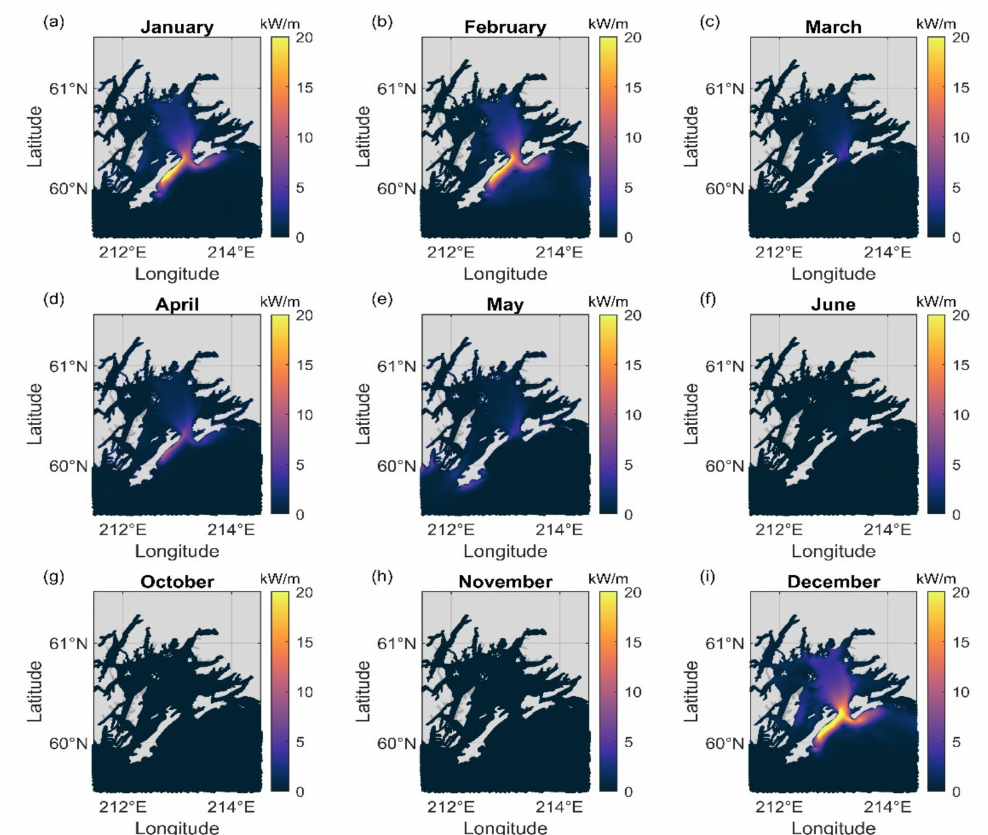
Figure 11. Prince William Sound: average power difference between the SWAN model without ice and the SWAN model with ice computed from 2016–2020. ( a ) January, ( b ) February, ( c ) March, ( d ) April, ( e ) May, ( f ) June, ( g ) October, ( h ) November, ( i )